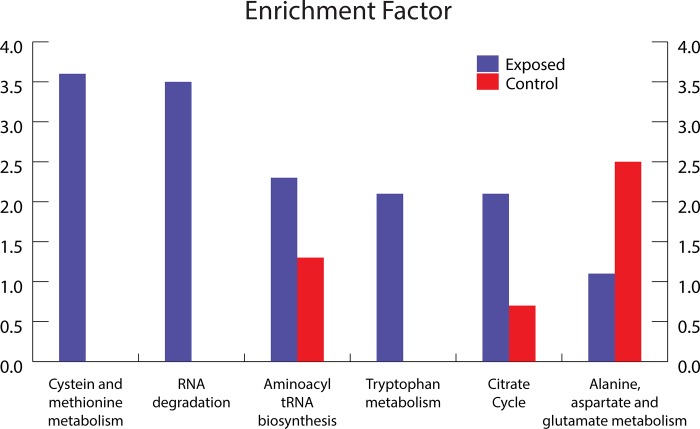
Bar plot of KEGG categories (x-axis) with corresponding enrichment factors (y-axis).Categories with a minimum enrichment factor of two for either UVC/vacuum (blue) treated or control (red) conditions are mapped. An enrichment factor of zero means that not a single protein in this category was upregulated in the displayed condition.